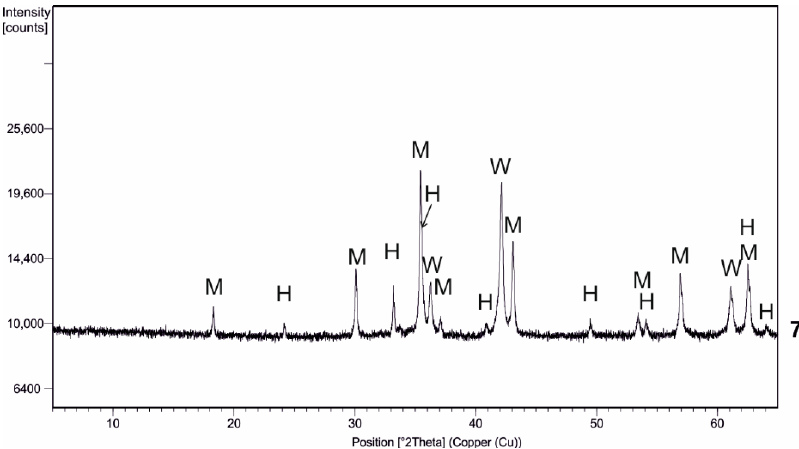
Figure 2. X-ray powder diffraction (XRD) pattern of sample No. 7 (scale). Symbol explanation: M — magnetite, H — hematite, W — wüstite.